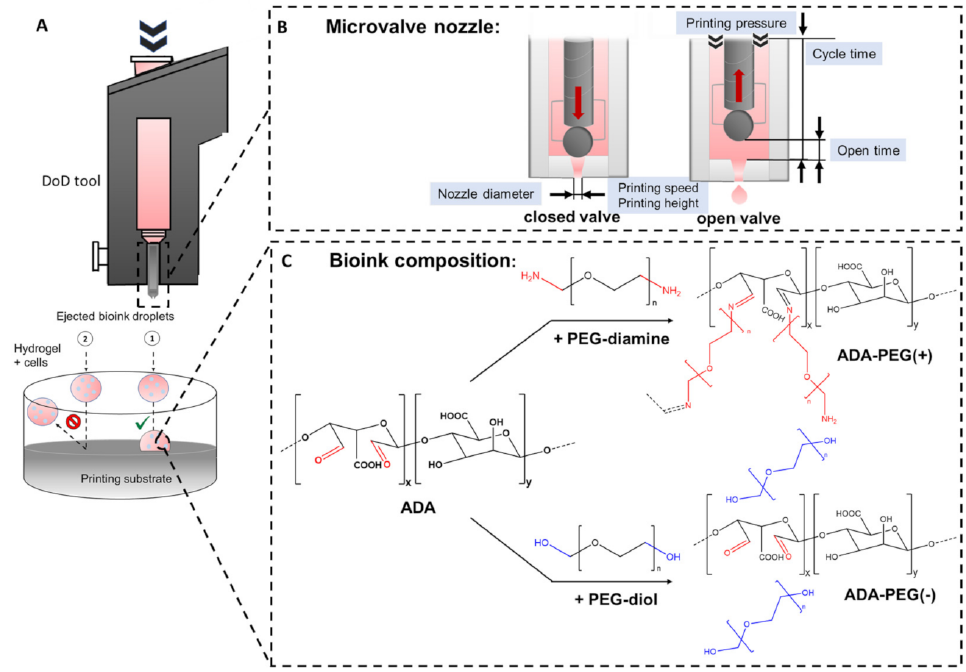
Figure 1. ( A ) Graphical illustration of a DoD tool and an attached (1, right) and unattached (2, left) ejected droplet on a printing substrate after ionically crosslinking with CaCl 2 ; ( B ) variable printing parameters of the DoD printer influencing droplet formation: nozzle diameter, printing pressure, open time, cycle time, printing speed and printing height; ( C ) chemical structures of starting materials ADA and PEG-diamine leading to covalently crosslinked ADA-PEG(+) and chemical structures of ADA and PEG-diol yielding in covalently uncrosslinked ADA-PEG(-)